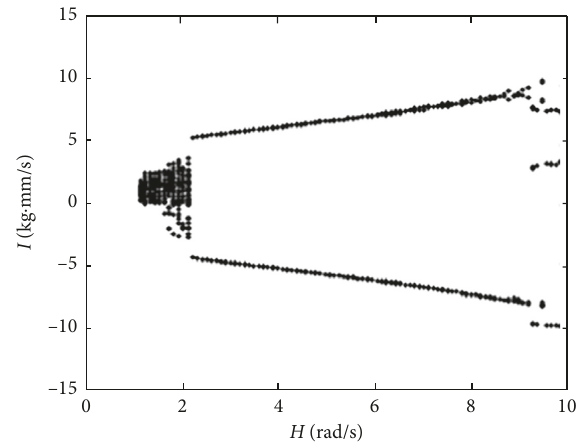
Figure 12: Bifurcation of impact intensity.